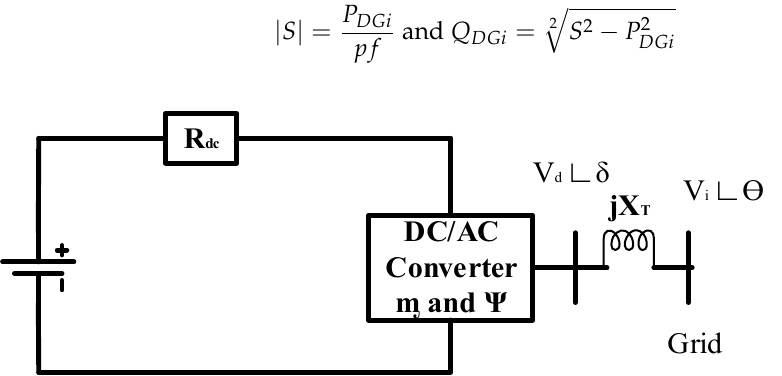
Figure 2. Circuit Diagram of power converter